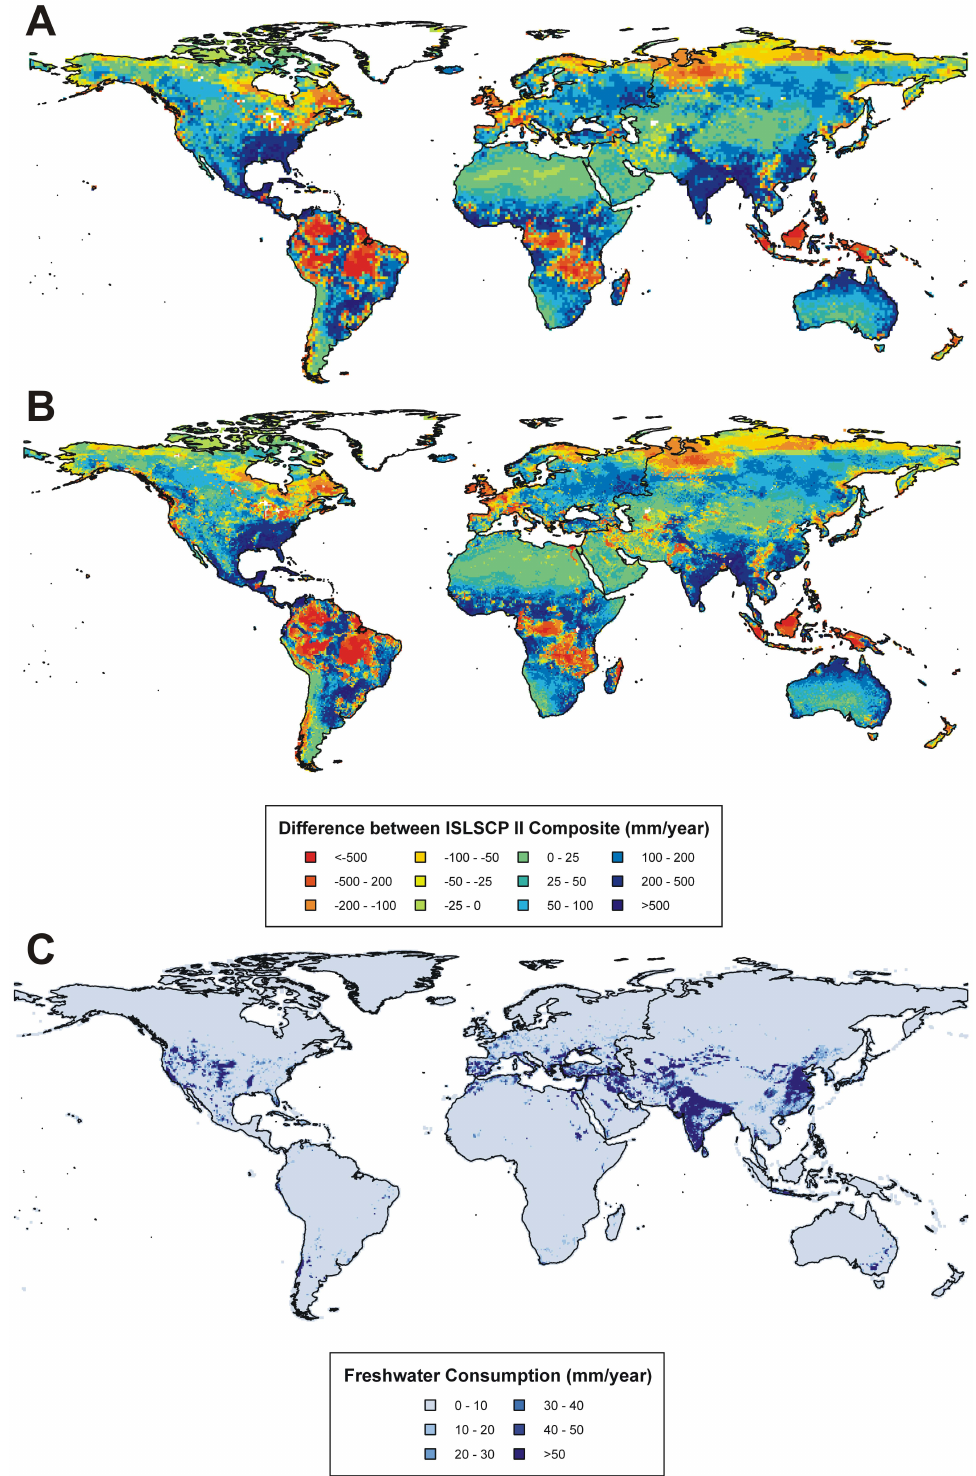
Fig. 4. (A) – Difference in LPX mean annual runoff (mmyear − 1 ) from the ISLSCP II composite dataset for the period 1986–1995. (B) – Difference in mean annual runoff for LPX and ISLSCP II (1986–1995) with mean annual freshwater consumption incorporated (mmyear − 1 ). (C) – Difference between former two figures to highlight regions where WaterGAP freshwater consumption (mmyear − 1 ) is important in influencing the discrepancies between LPX and ISLSCP II runoff